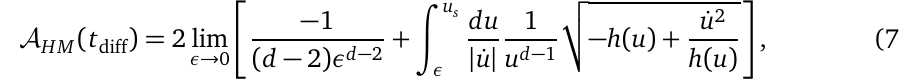
Figure 10: The minimum area versus time for the black string geometry with u and d =